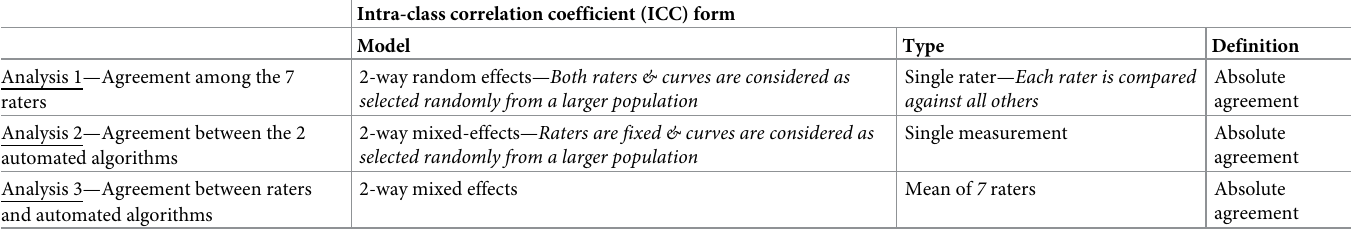
Table 1. Details of the ICC form chosen for analyses 1, 2 and